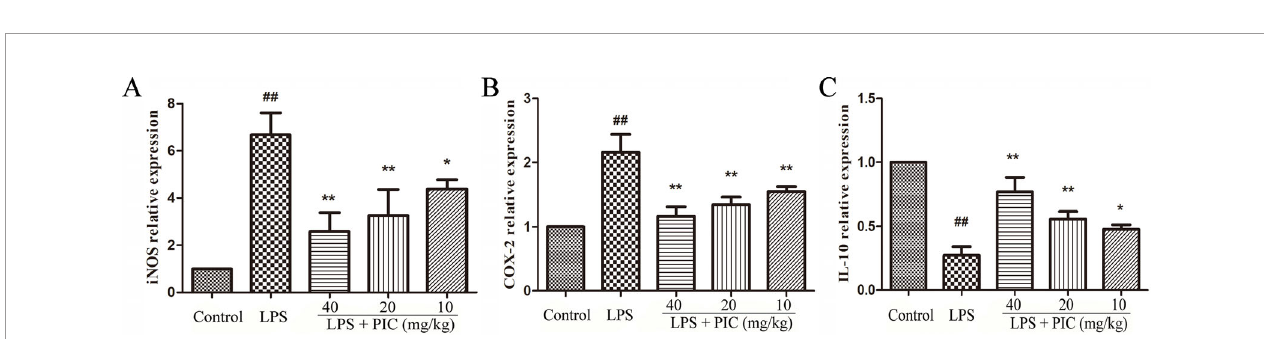
FIGURE 7 | The messenger RNA (mRNA) expression of (A) inducible nitric oxide synthase (iNOS), (B) cyclooxygenase (COX)-2 and (C) interleukin (IL)-10. The transcriptional levels of iNOS, COX-2, and IL-10 were analyzed using quantitative real-time (qRT)-PCR. ## p < 0.01 is signi fi cantly different from the control group; * p < 0.05 and ** p < 0.01 are signi fi cantly different from the lipopolysaccharide (LPS)